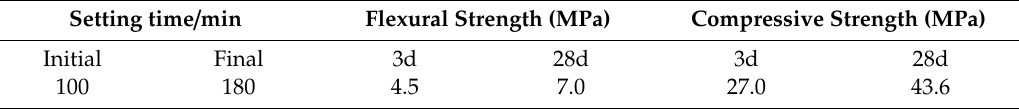
Table 2. Physical properties of the